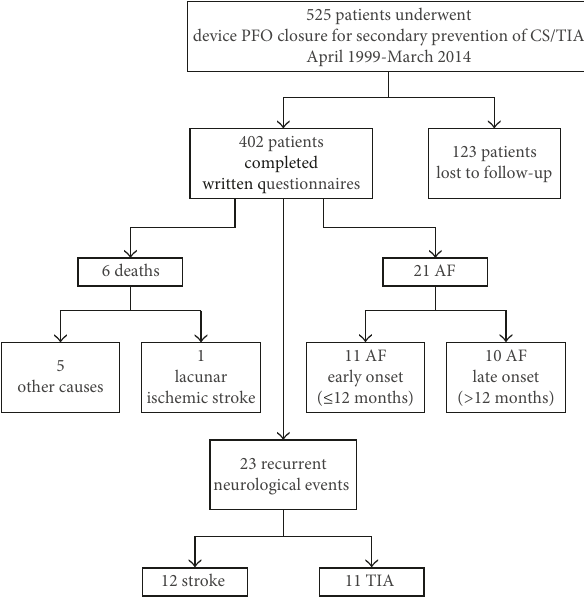
Figure 1: Flowchart demonstrating events at